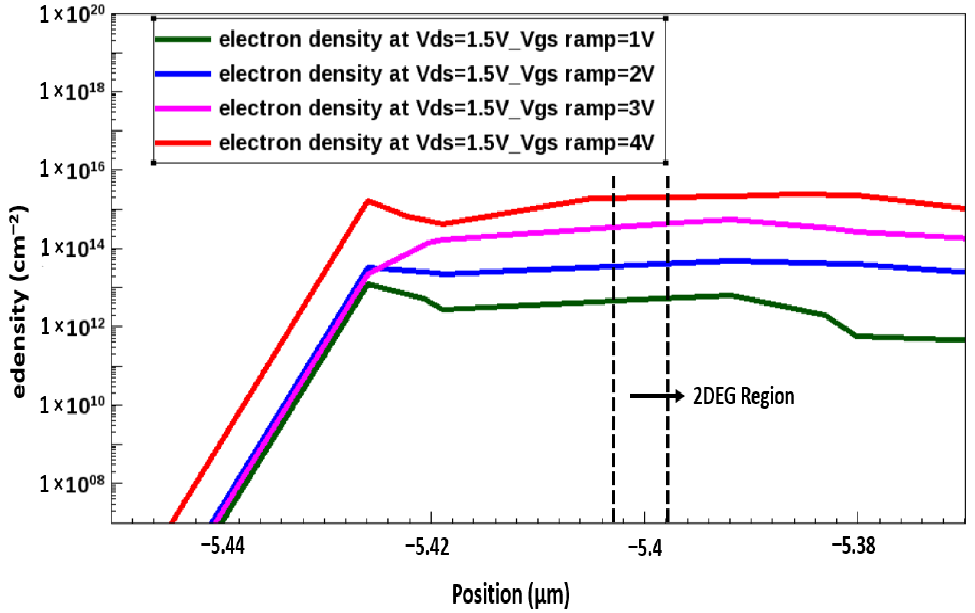
Figure 3. 2 DEG density after nitrogen implantation for AlGaN/GaN HEMT.